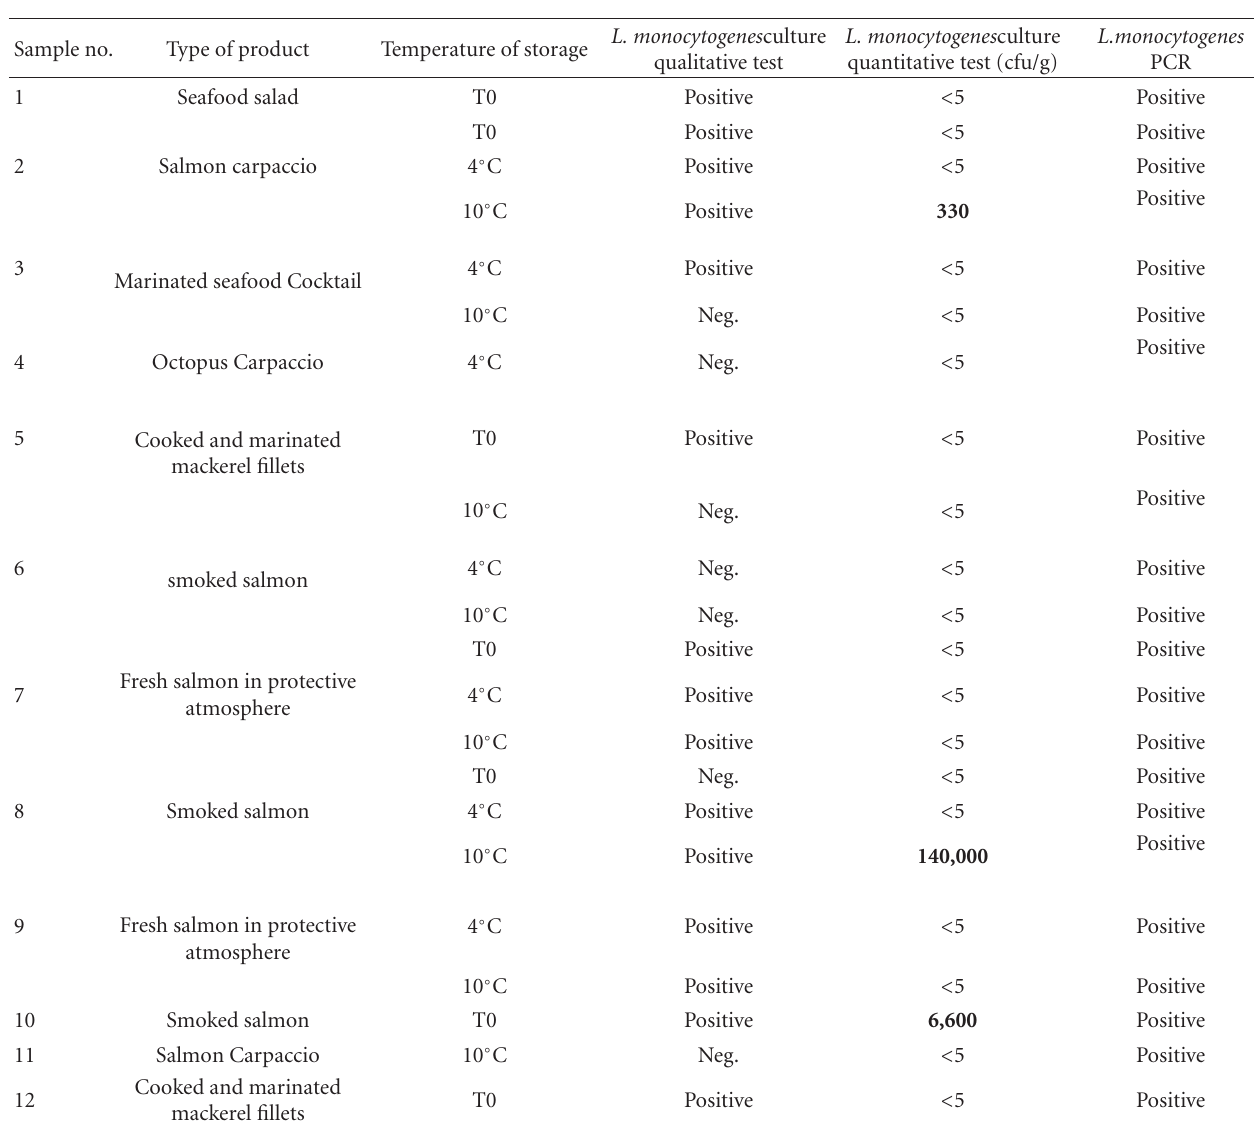
Table 2: Products resulting positive to L.